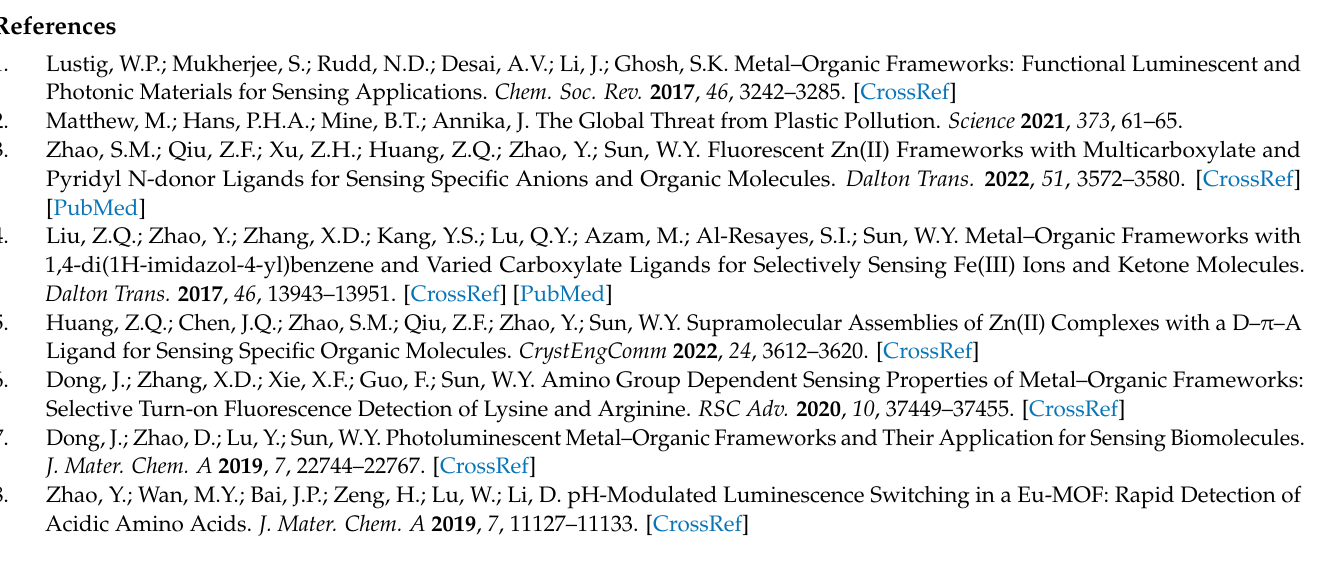
solvent; Figure S7: Fluorescence spectra of MOF 1 and its ligands H 3 NTB and DPA in the solid state; Figure S8: PL spectra of 1 after immerging in varied solvent; Figure S9: Fluorescence quenching effect of 1 by adding amino acid aqueous solution (300 µ L, 2.5 mM, λ ex = 338 nm); Figure S10: PXRD and FTIR-ATR spectra of MOF 1 before and after detecting Glu and Asp; Figure S11: Fluorescence emission spectra of 1 and UV absorption spectra of Glu and Asp in water; Figure S12: Fluorescence lifetime of 1 before and after detecting Glu (a) and Asp (b) in water; Figure S13: The standard curve of MOF 2 for the UV absorption versus concentration of RhB; Figure S14: The degradation efficiency of RhB at varied reaction time; Figure S15: The concentration of RhB in the degradation process at acidic (pH = 2 and 5) and basic (pH = 8 and 10) conditions; Figure S16: The degradation efficiency of RhB by 2 at acidic (pH = 2 and 5) and basic (pH = 8 and 10) conditions. Figure S17: The concentration of RhB at varied photodegradation time with different radical trapping agents; Figure S18: The EPR spectra of photodegradation of RhB by MOF 2 at different reaction time using DMPO as spin-trapping agent; Figure S19: UV-vis diffuse reflectance spectrum (a) and Tauc plot (b) of MOF 2 ; Figure S20: EIS Nyquist plot of MOF 2